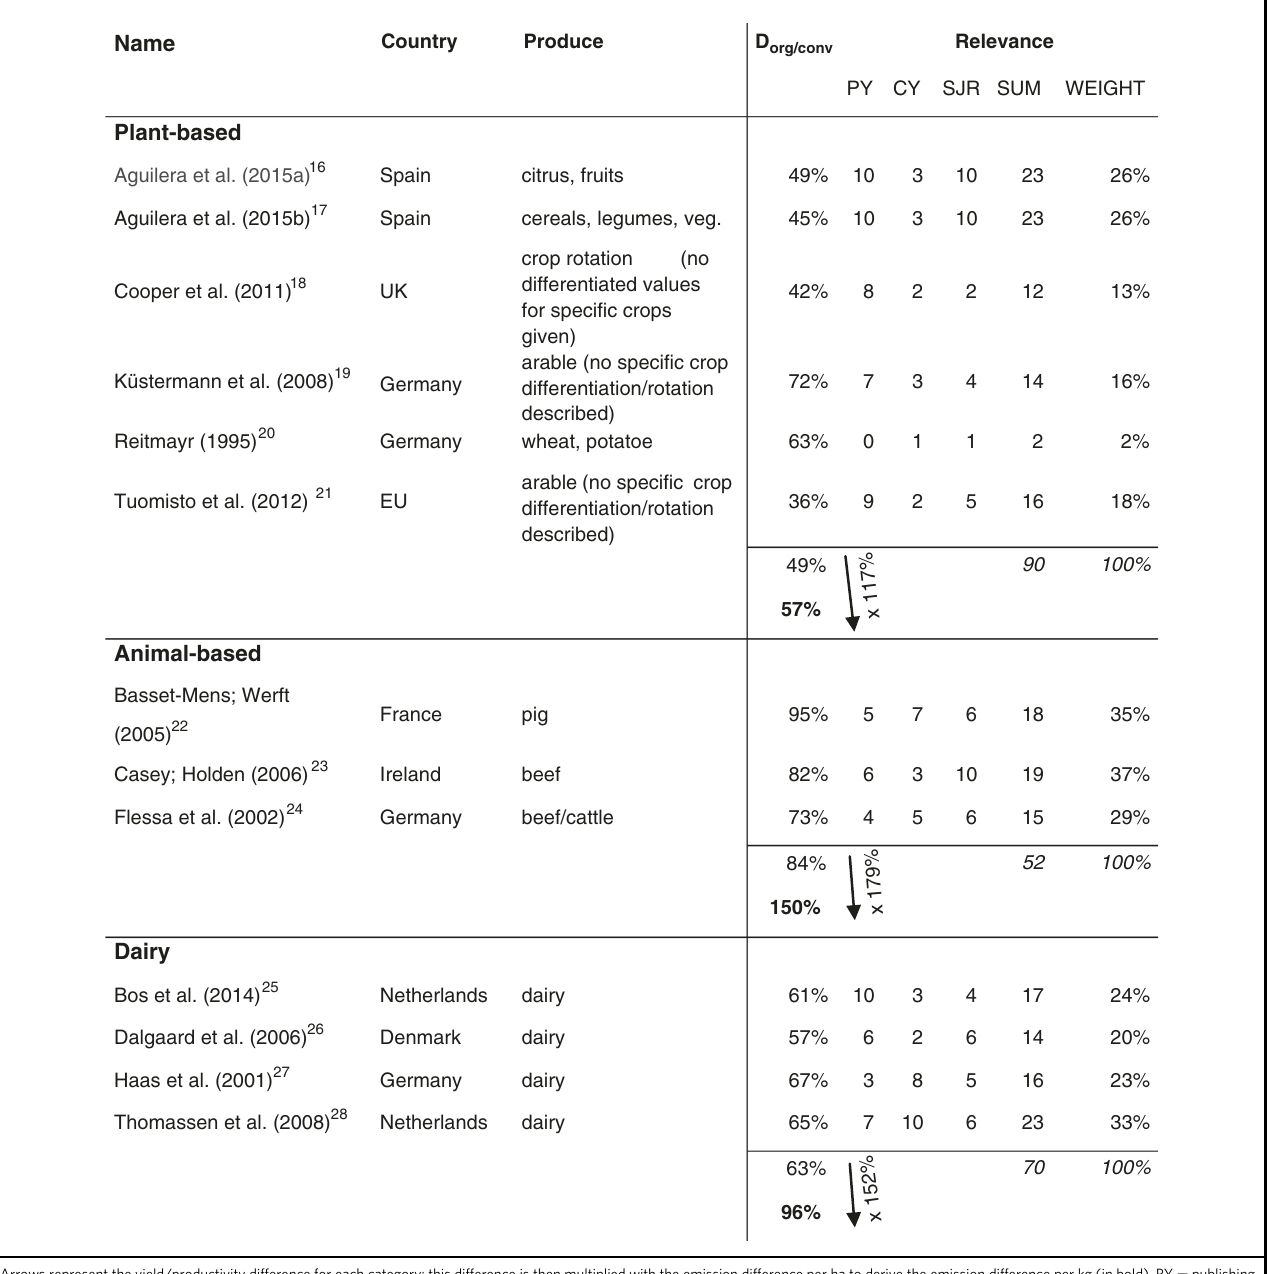
Arrowsrepresenttheyield/productivitydifferenceforeachcategory;thisdifferenceisthenmultipliedwiththeemissiondifferenceperhatoderivetheemissiondifferenceperkg(inbold).PY = publishing year, CY = yearly citations, SJR = SciMago journal ranking, SUM = sum of all three factors, WEIGHT = weighted sums of category. A more detailed explanation of the studies ’ speci fi cs including the weighting scheme can be found in the Supplementary Note 1 and Table 1. Source data are provided as a source data fi